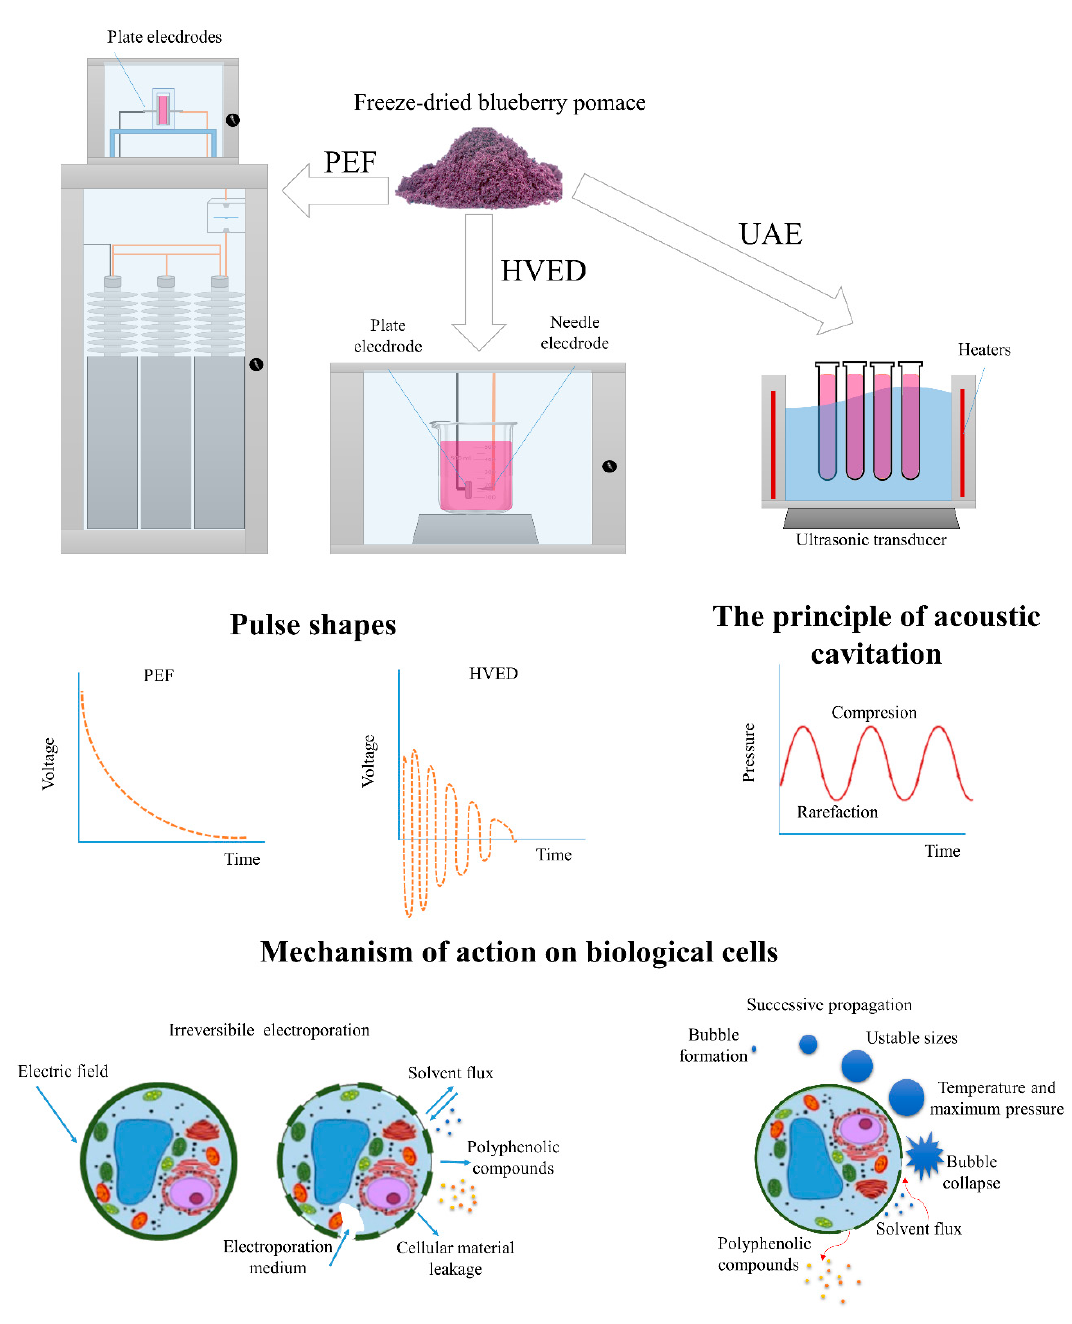
Figure 1. Example of processing chambers, pulse shapes used, and mechanism of action of used extraction techniques. PEF—pulsed electric field; HVED—high-voltage electrical discharge; UAE—ultrasound-assisted extraction.